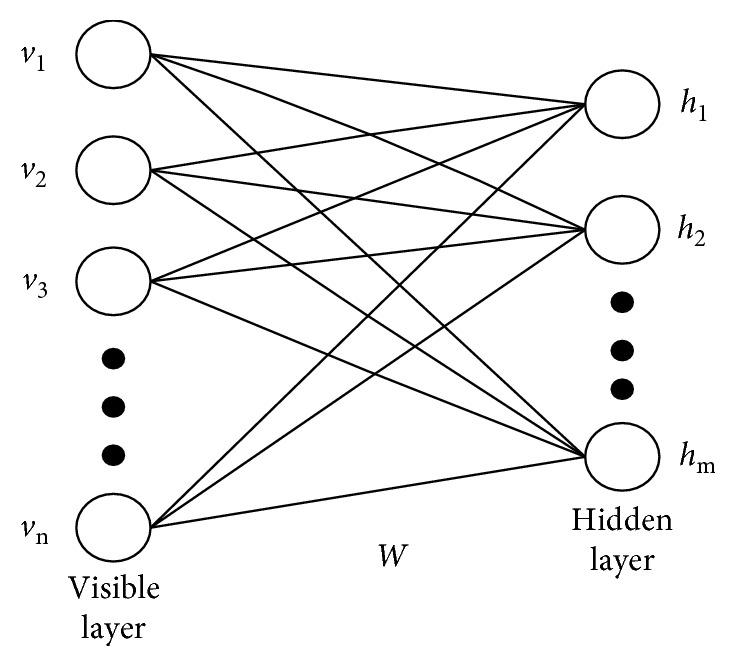
Restricted Boltzmann machine undirected configuration diagram.